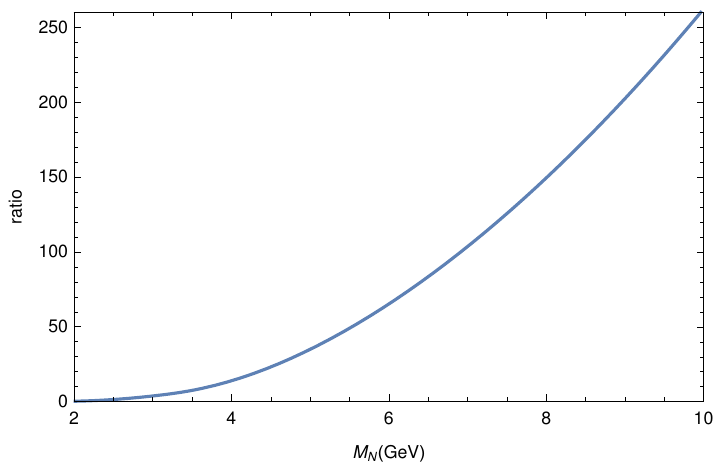
U ¯ D ) / Γ( N → ‘ − π + ) , as a function of mass M N of 2 2